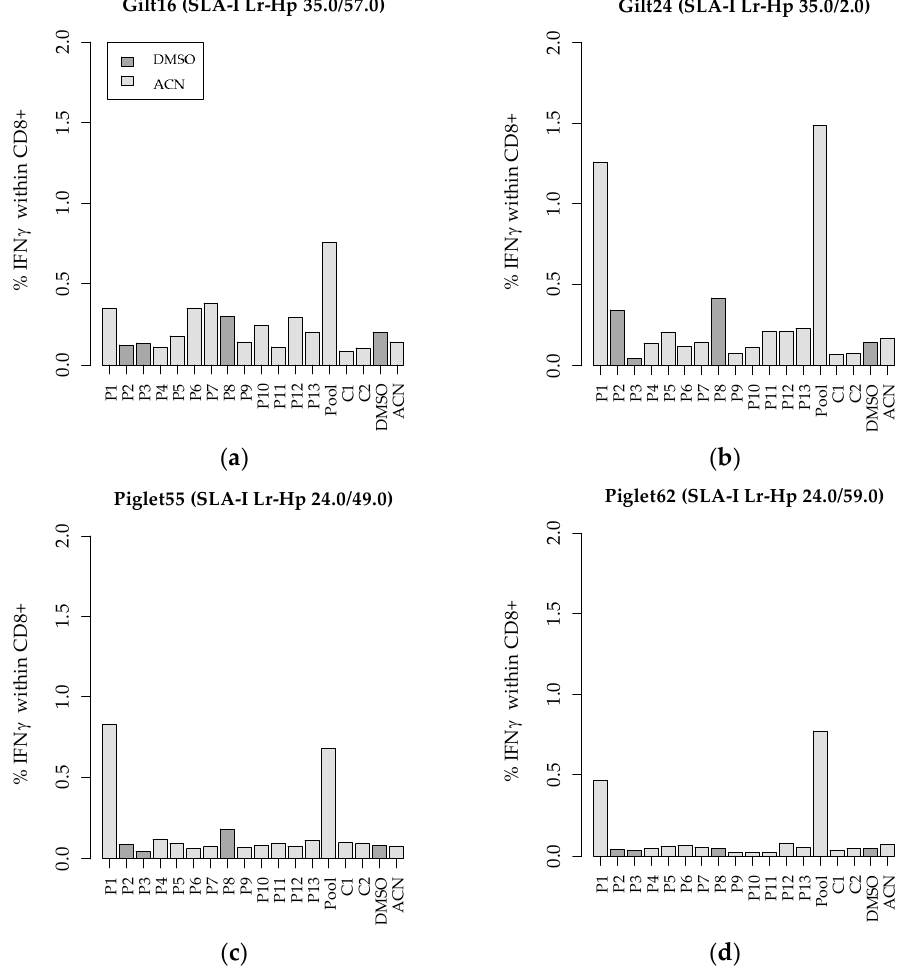
Figure 5. IFNγ-producing cells within the total CD8 + T-cell population after restimulation of PBMCs with MHC-I-bound porcine and PRRSV-derived peptides. PBMCs were isolated from two gilts ( a , b ) and two piglets ( c , d ). P, PRRSV-derived peptides; C, control peptides from naïve cells; DMSO and CAN, medium control; Pool, pool of all 13 PRRSV peptides. SLA-I low-resolution haplotypes (Lr-Hp) of the donor animals are indicated above each graph.